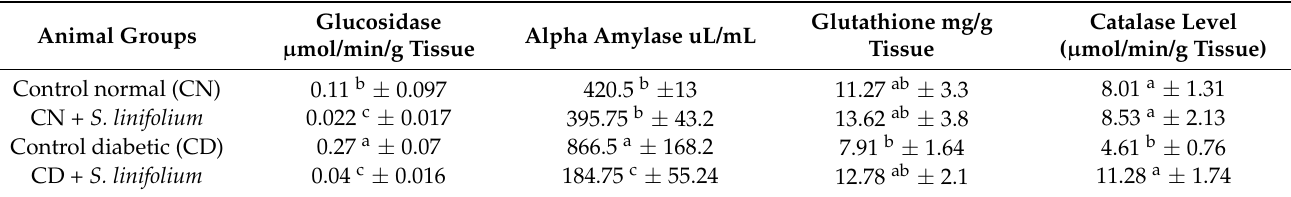
Table 4. Serum glucosidase, alpha-amylase, catalase, and glutathione in the treated rat